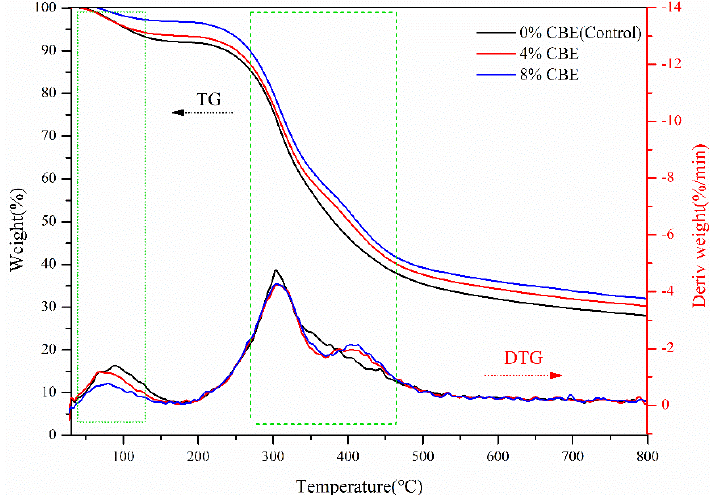
Figure 5 . TG/DTG curves of soybean protein ‐ based adhesives with different CBE content. Figure 5. TG/DTG curves of soybean protein-based adhesives with different CBE